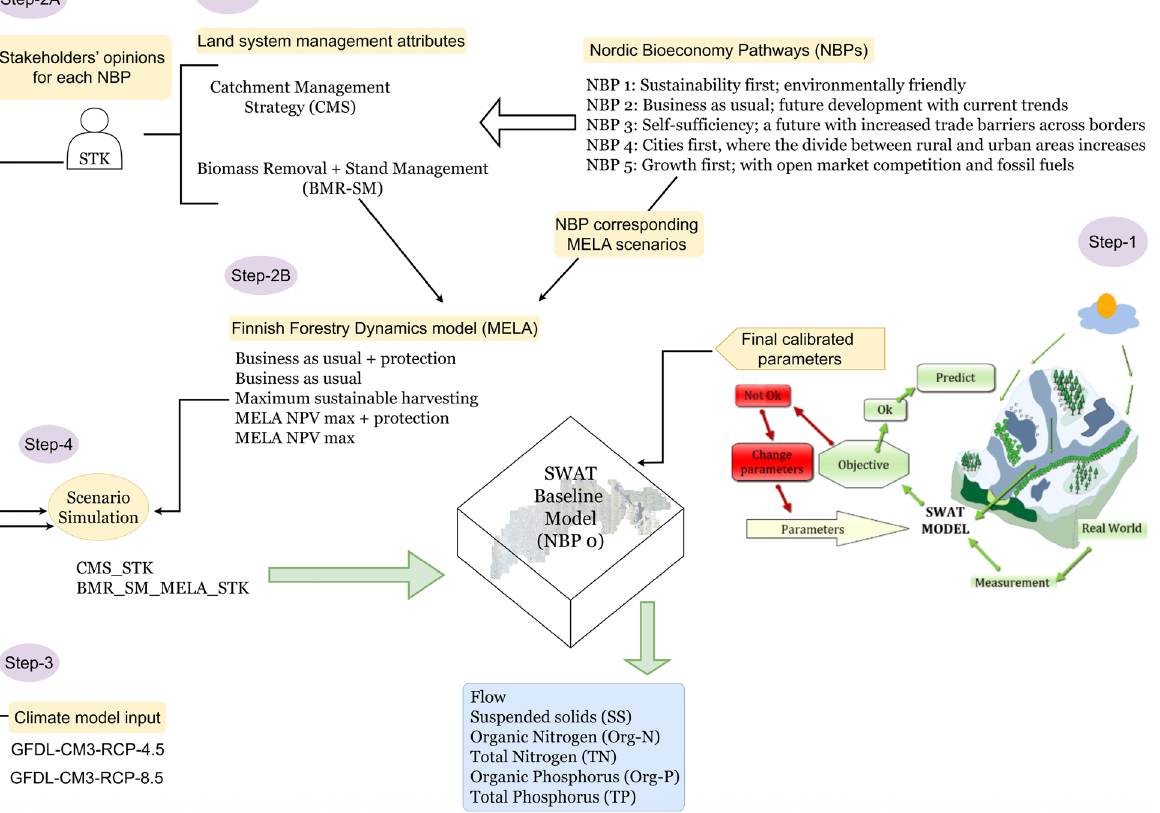
Figure 2. Detailed processes to implement NBP